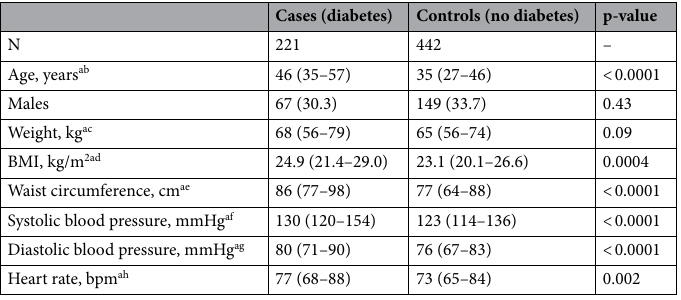
Table 1. Participant characteristics. Data expressed as n (%) or a median (IQR). Data not available in b 2, c 1, d 10, e 22, f 3, g 9 and h 17 participants.